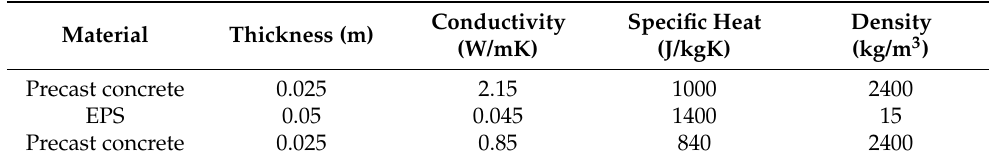
Table 3. Stratigraphy settings for precast concrete panels.